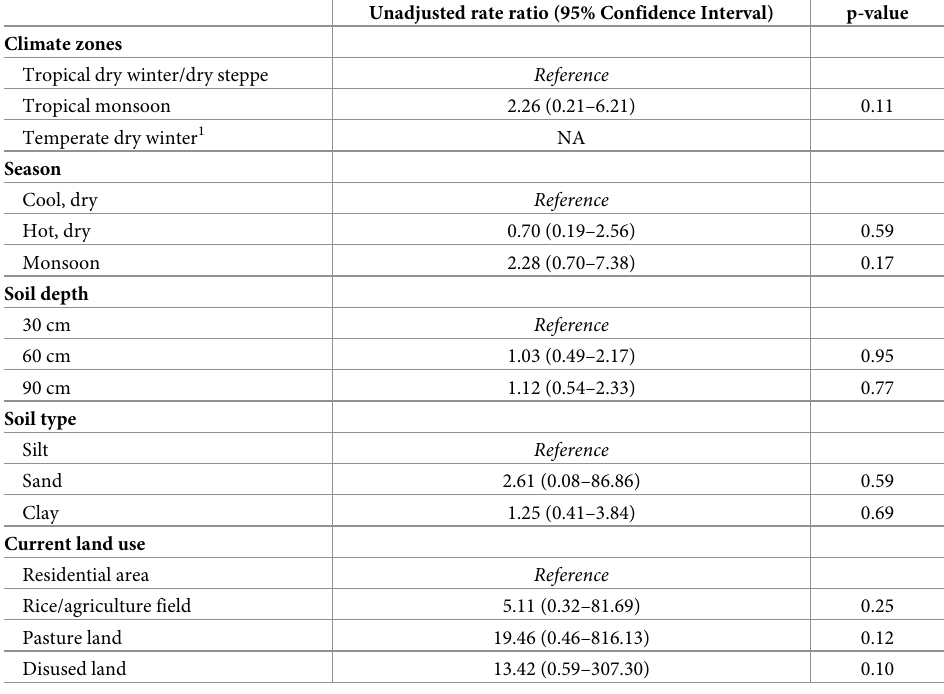
Table 2. Association between B . pseudomallei isolation in the soil samples and season, soil depth, soil types, cur- rent land use and climate zones.